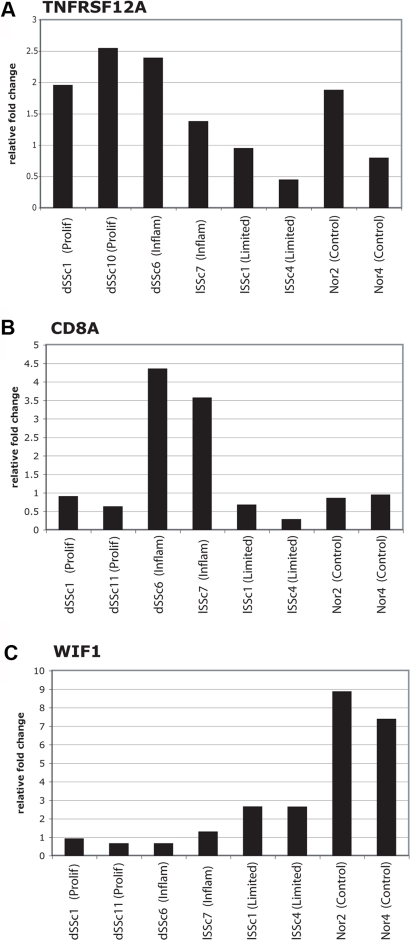
Quantitative Real Time PCR analysis of representative biopsies.The mRNA levels of three genes, TNFRSF12A (A), CD8A (B) and WIF1 (C) were analyzed by Taqman quantitative real time PCR. Each was analyzed in two representative forearm skin biopsies from each of the major subsets of proliferation, inflammatory, limited and normal controls. In the case of TNFRSF12A, patient dSSc11 was replaced by patient dSSc10, which cluster next to one another in the intrinsic subsets and show similar clinical characteristics (Table 1). Each qRT-PCR assay was performed in triplicate for each sample. The level of each gene was then normalized against triplicate measurements of GAPDH to control for total mRNA levels (see materials and methods). The relative expression values are displayed as the fold change for each gene relative to the median value of the eight samples analyzed.